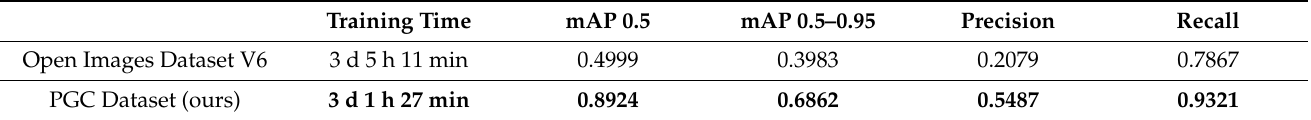
Table 3. Dataset Performance comparison with open image datasetv6 on scaled yolov4.